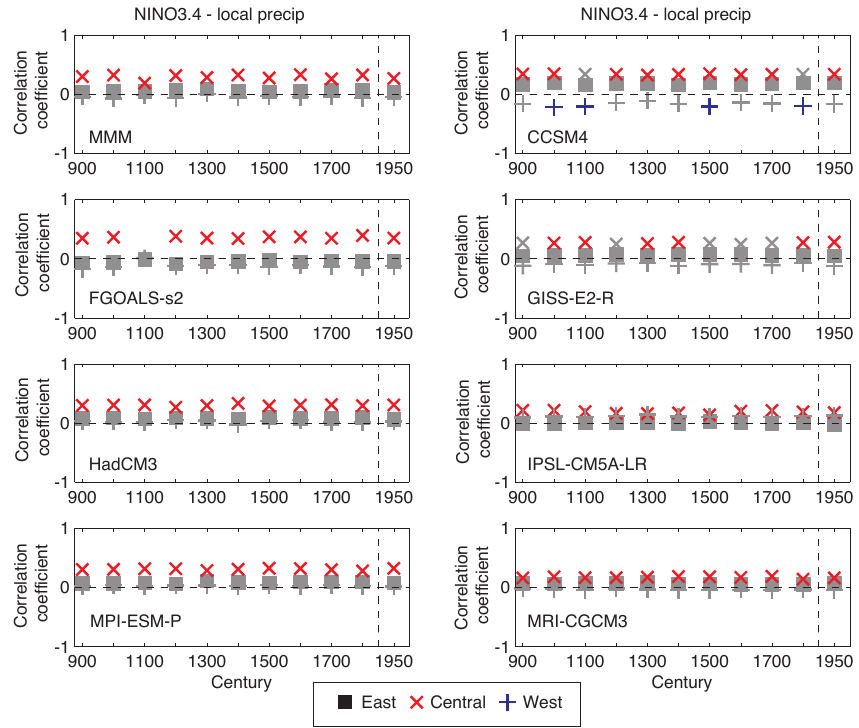
Figure 8. As for Fig. 7 but showing correlation coefficients ( R ) of NINO3.4 and local precipitation.